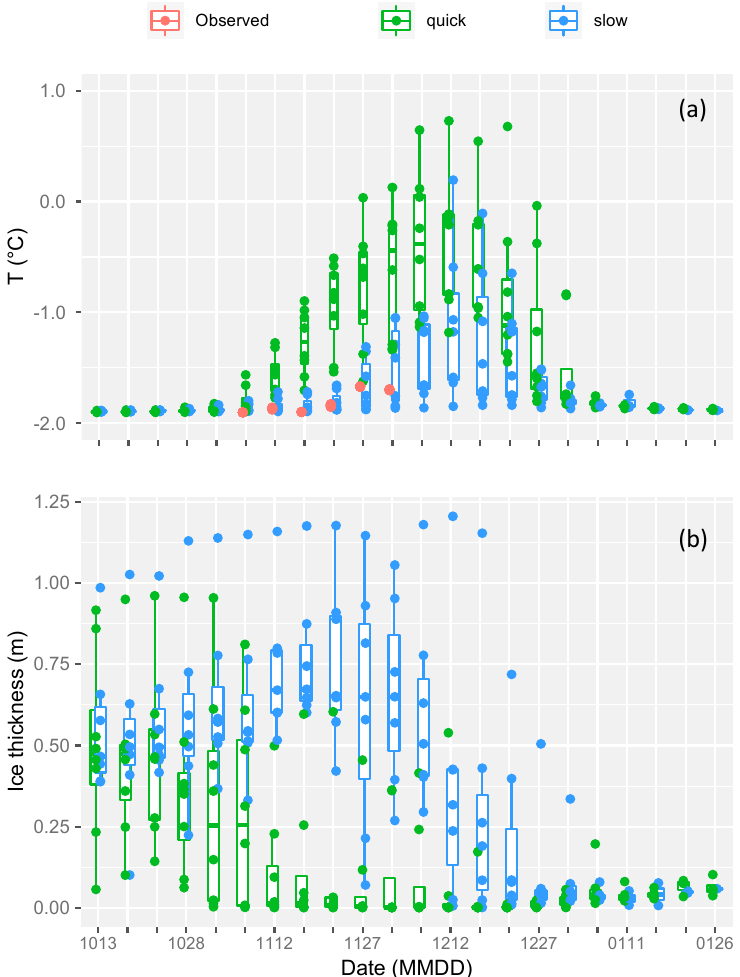
Figure 5. ( a ) Comparisons of simulated vs. measured surface water temperature. ( b ) Simulated trend of ice thickness at the PIPEX station from mid-October to end of January. Years are classified as quick/slow-melting. The observed temperature measured with the CTD in the 5–8 m layer (in red) are representative of a typical year of slow (or delayed) melting in the area. The date is coded as MMDD, from 13 October (1013) to 26 January (0126).